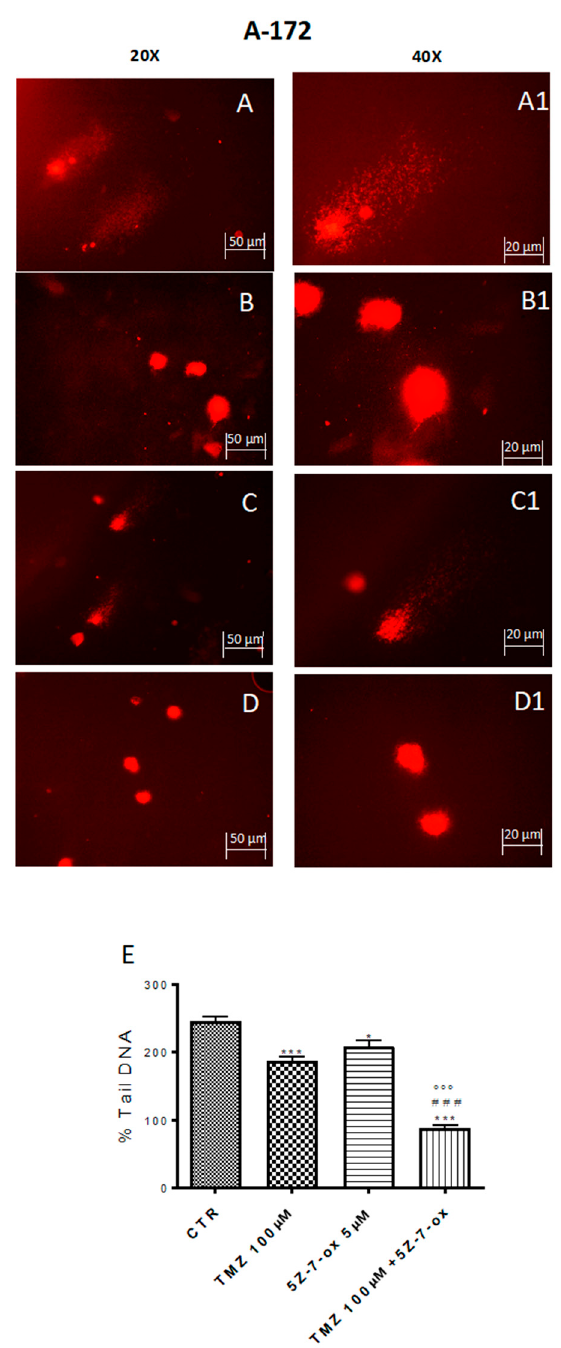
Figure 3. Effect of 5Z-7-ox and TMZ on DNA damage in A172 cell line. Alkaline comet assays (% tail DNA as comet pattern) were taken to quantify DNA damage. Panel ( A ) and densitometry in ( E ) shows the comet patterns obtained in glioblastoma control group, whereas panel ( B , C ) shows the comet pattern recorded from pre-incubation with TMZ and 5Z-7-ox indicating that pre-treatment was efficacious in reducing DNA damage, however panel ( D ) demonstrates how the association significantly reduced the % of DNA tail. ( A1 – D1 ) shows the high magnification at 40×. The graph ( E ) shows the densitometry analysis of comet patterns. Data are representative of at least three independent experiments. *** p < 0.001 vs. CTR, ### p < 0.001 vs. TMZ and °°° p < 0.001 vs. 5Z-7-ox.